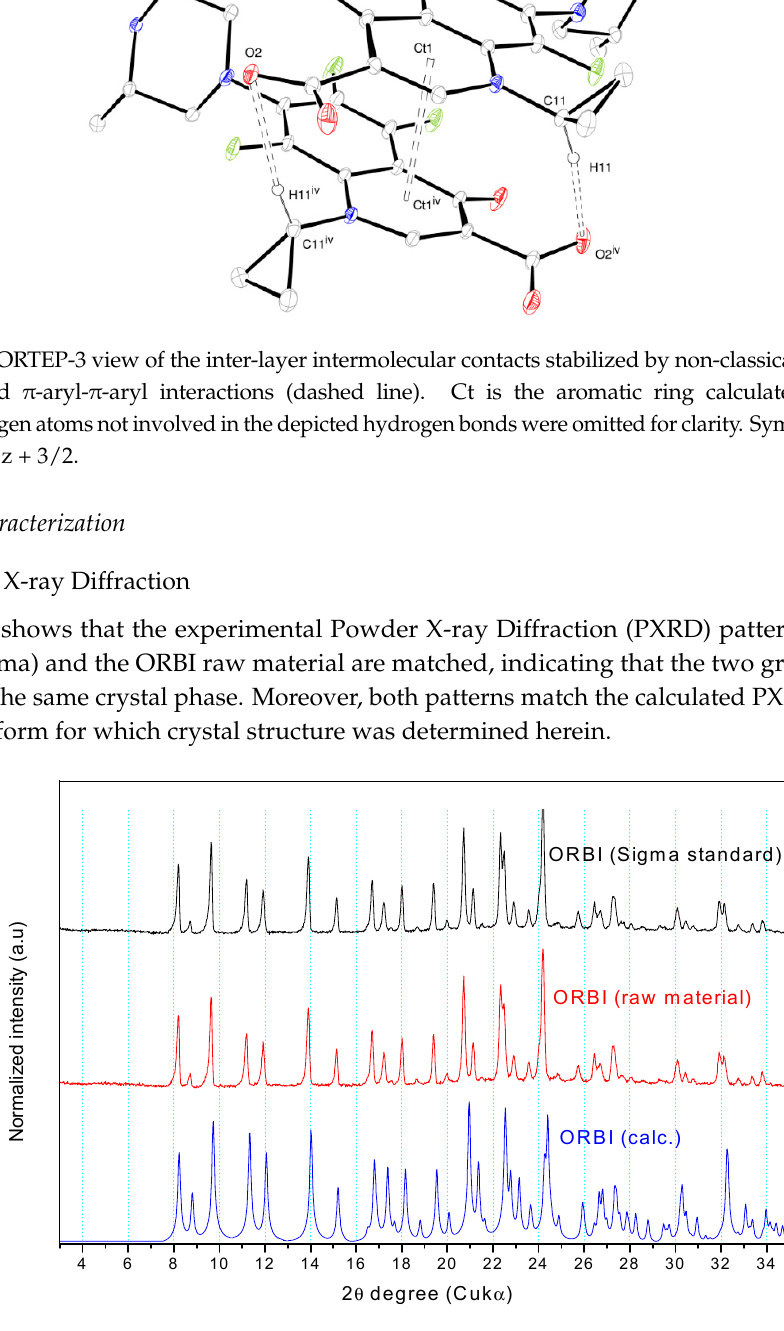
Figure 7. Experimental and calculated PXRD patterns of ORBI. The calculated pattern is in blue, and the experimental patterns for the raw material and the Sigma standard are in red and black, respectively.